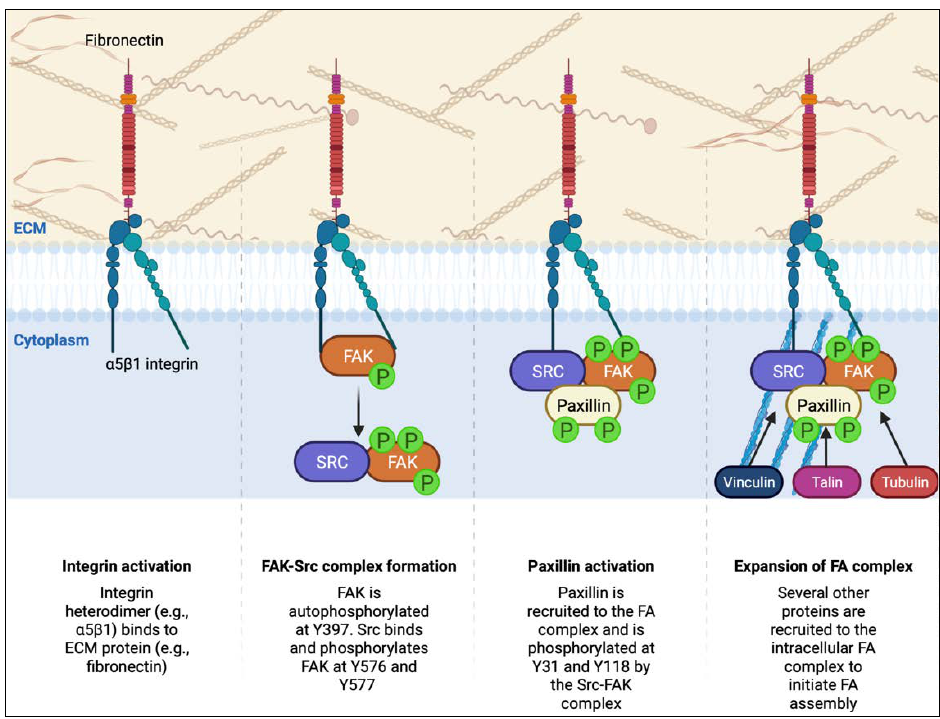
Figure 3. Focal adhesion initiation signaling. (ECM — extracellular matrix; FA — focal adhesion; FAK — focal adhesion kinase; Y — tyrosine). Integrins form dimers and interact with extracellular matrix proteins. Inside the cell, the action of focal adhesion kinase and Src facilitates the assembly